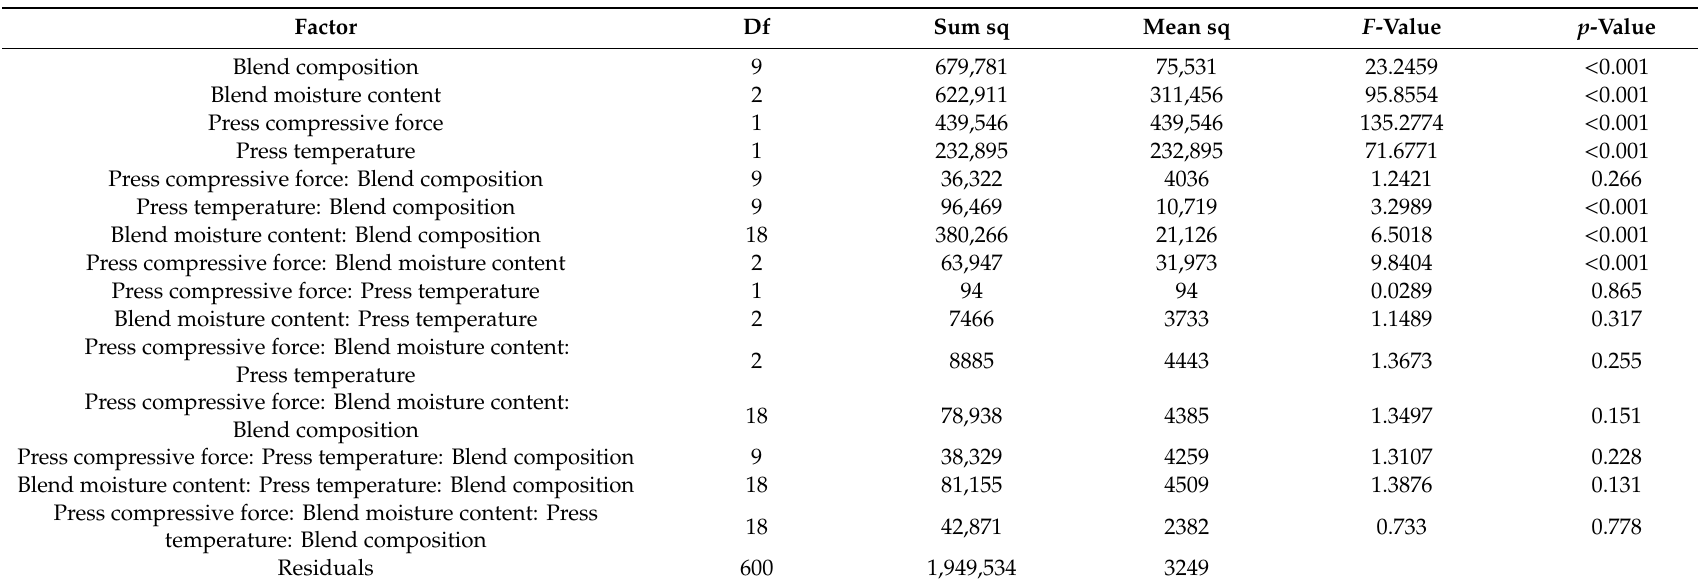
Table 4. Parameters and p-values from ANOVAs testing the e ff ects of blend composition, moisture content, press compressive force, and temperature on pellet density. Df = Degrees of freedom. Sum sq = Sum of squares. Mean sq = Mean